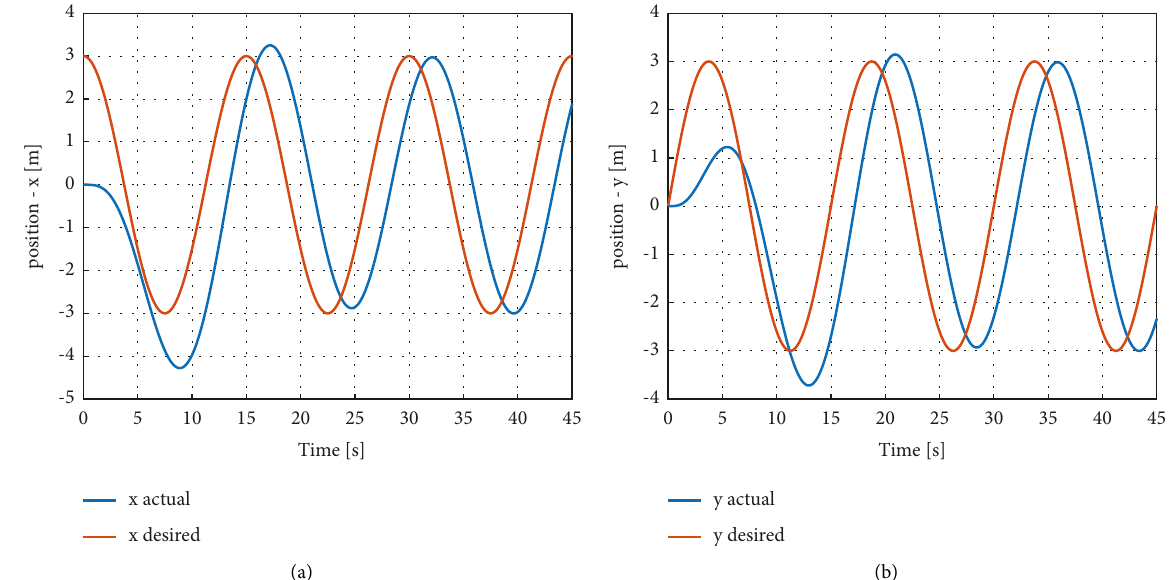
Figure 12: Coordinate-wise comparison between desired and actual trajectories of Figure 11.